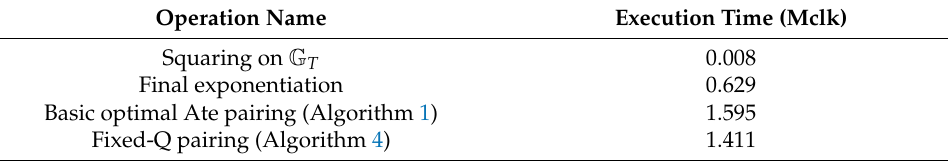
Table 1. Execution times of the operations constituting an inner-pairing product.